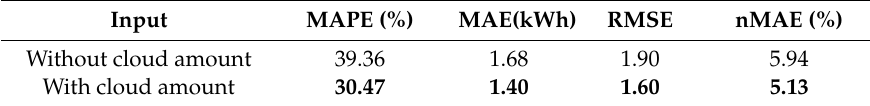
Table 2. Comparison of photovoltaic (PV) power generation forecasting performance.